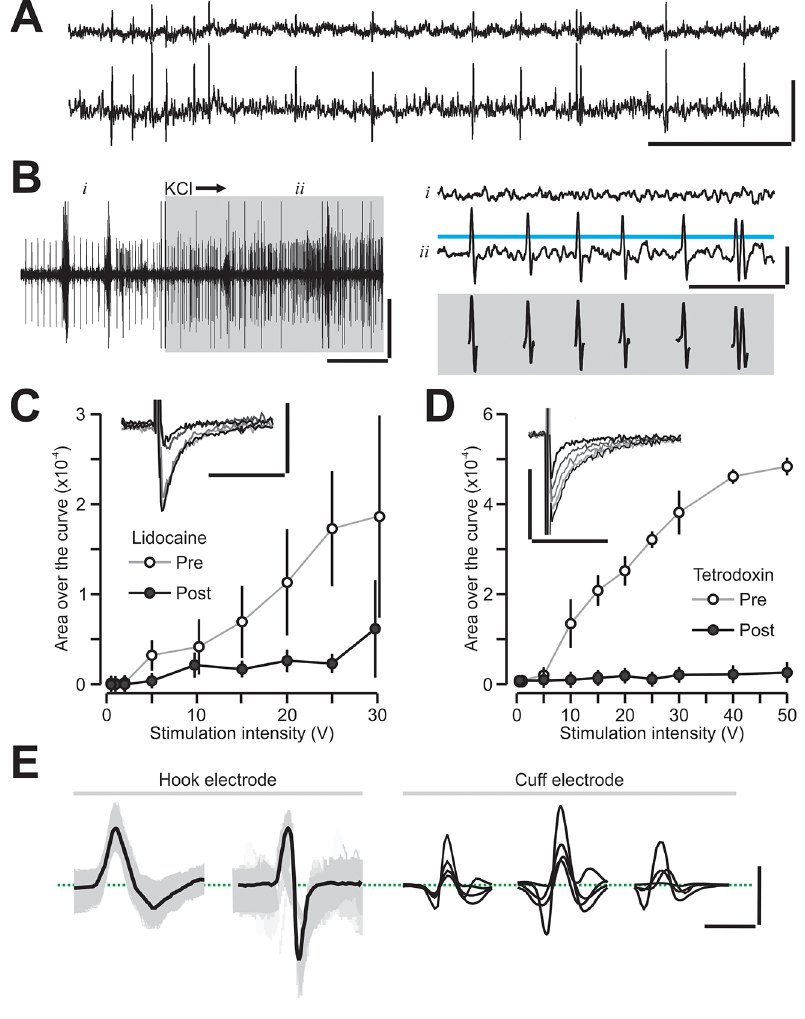
Figure 2. Recording compound action potentials in the vagus nerve. (A) Simultaneous recordings (two of three electrodes are shown) of spontaneous activity in the vagus nerve. (B) (Left) Vagus nerve excitation by KCl (4 mM, gray box) applied to the surgical field. (Top right) Period of quiescent activity before KCl (marked by i ). (Middle) Period of intense spiking during KCl (marked by ii ). Blue line indicates the adaptive threshold used to detect compound action potentials (CAPs). (Bottom) Isolated CAPs are aligned with the trace above. (C) (Inset) Brief electrical pulses stimulate the vagus nerve and produce evoked CAPs. The graph shows the CAP area (mean ± SD), which becomes larger with increasing stimulation intensity (pre circles). Lidocaine (2%) largely blocks the evoked CAPs (post circles). (D) (Inset) Evoked CAPs previous to treatment with tetrodotoxin (100 μM). The graph shows the CAP area (mean ± SD), which is completely blocked by the drug. (E) Representative firing of single unit fibers obtained with hook and cuff electrodes. Scale bars (x, y), A , 100 ms, 100 μV; B left, 1 sec, 20 μV; B right , 10 ms, 20 μV; C, D , 2 ms, 40 μV; E, 2 ms. 10